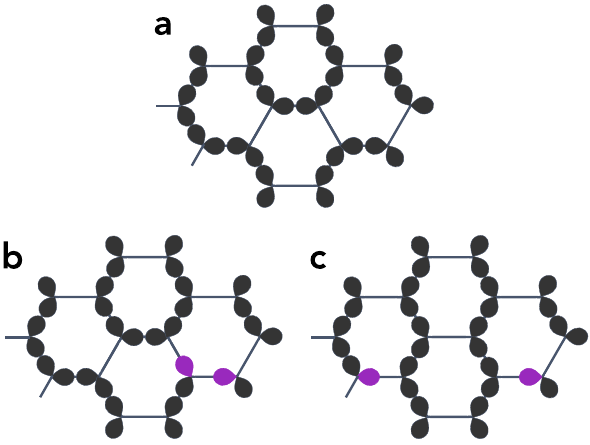
Fig. 3 Pictorial representations of the loop and orbital con fi gurations. a Orbital loop covering the lattice. b , c An elementary defect in the loop covering: b at the loop cut and c after part of the defect traveled. When the orbital loops are decorated by Haldane chains, the (purple) chain ends also carry a